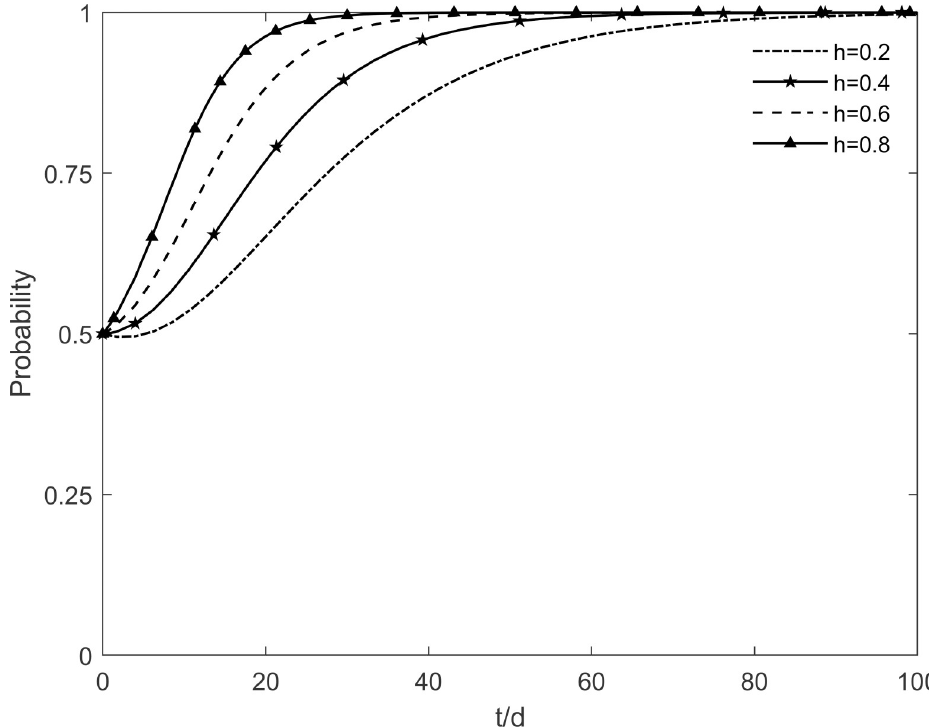
Fig 4. The impact of h on the investment retrofitting enterprises’ strategic choices. https://doi.org/10.1371/journal.pone.0282314.g004 PLOS ONE | https://doi.org/10.1371/journal.pone.0282314 March 16,